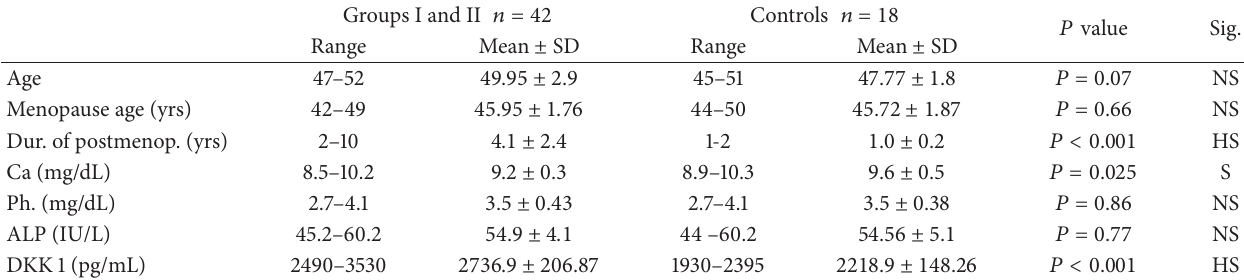
Table 1: Comparison between postmenopausal females with abnormal DXA results (groups I and II) and normal DXA results (controls) regarding demographic and laboratory data.